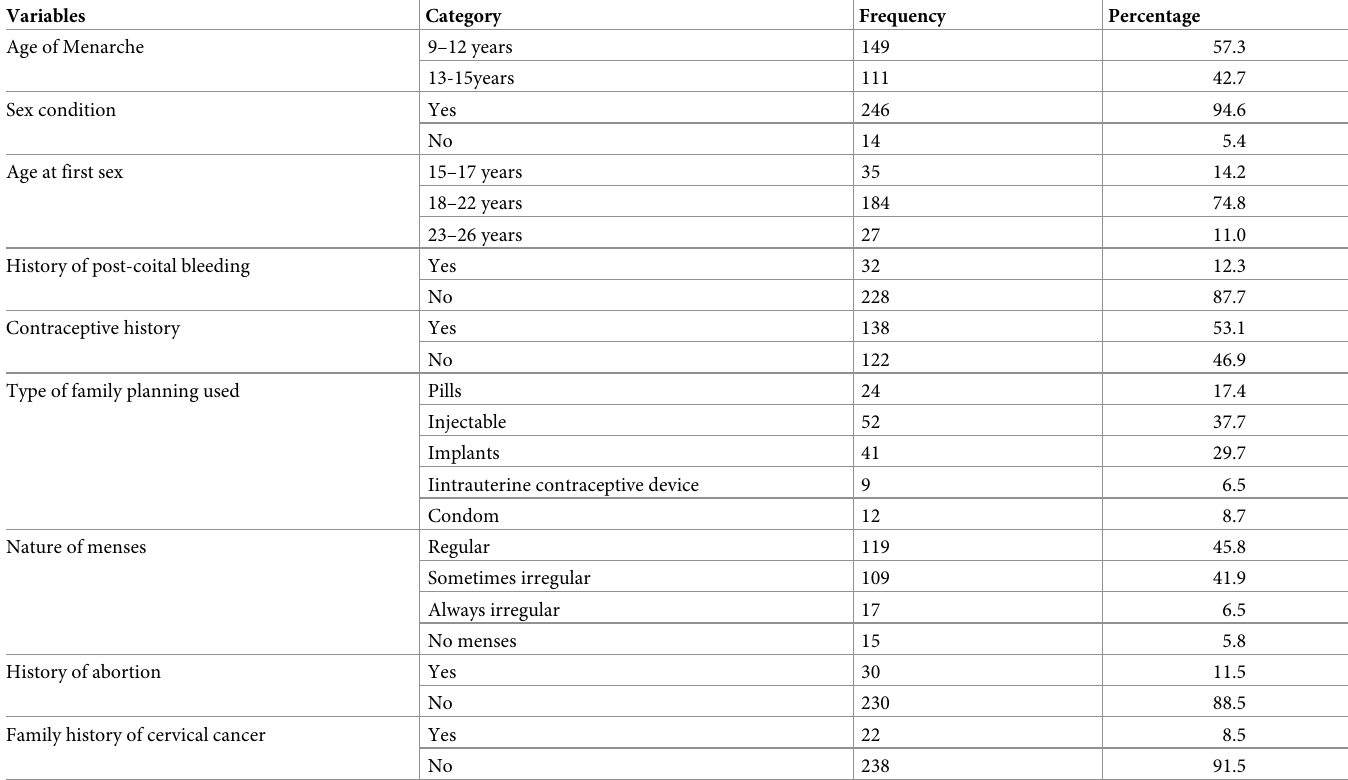
Table 2. Reproductive characteristics of respondents among reproductive age group women in districts of Gurage zone, Southern Ethiopia,